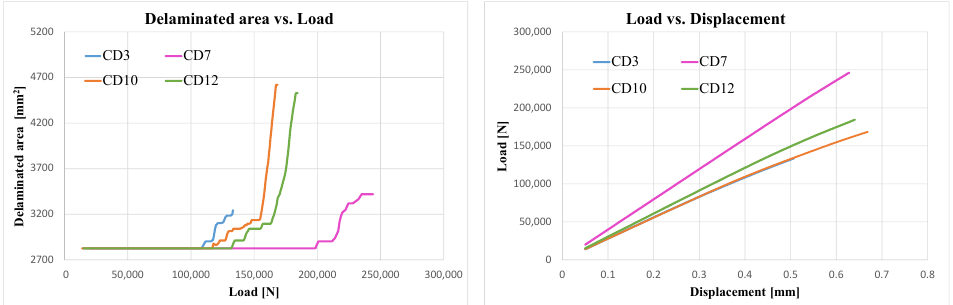
Figure 14. Delaminated area vs. load and load vs. displacement charts. Comparison against CD3, CD7, CD10 and CD12 configurations.